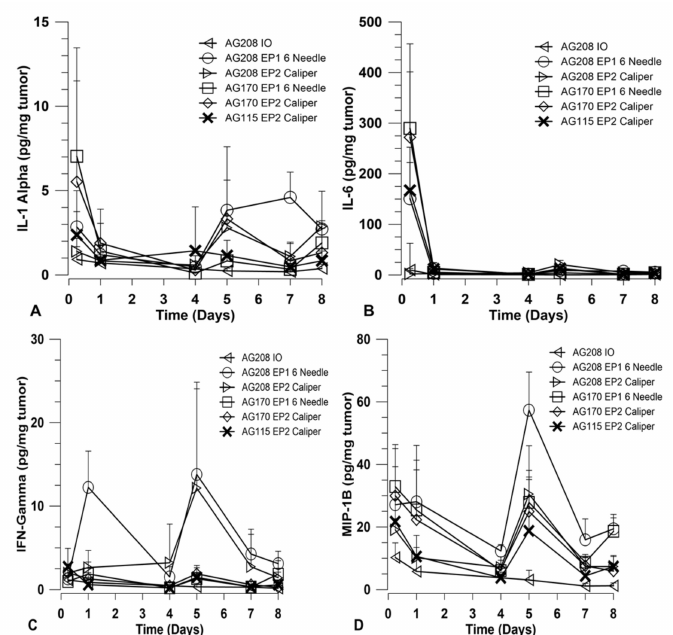
Figure 4. IL-15 GET induces cytokine in the tumor microenvironment. Cytokine levels were measured using a multiplex assay from tumor homogenate collected at various time points during the treatment protocol. Cytokines included in the multiplex were IFN γ , IL-1 α , IL-6, IL-10, IL-12 p40, IL-12 p70, IL-15, IP-10, MCP-1, MIP-1 β , and TNF α . Results are shown for cytokines that were observed to have variation between groups. pDNA was delivered on days 0, 4, and 7. Data are represented as the mean expression for each group. ( A ) levels of IL-1 α ; ( B ) levels of IL-6; ( C ) levels of IFN γ ; ( D ) levels of MIP-1 β . Error bars represent the standard deviation. n = 4 for each